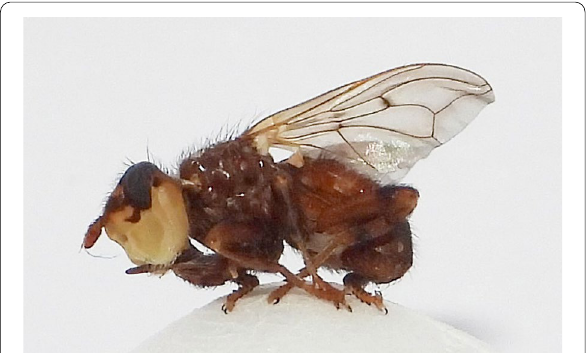
Fig. 3 Myopa pellucida (Robineau‑Desvoidy, 1830) male, lateral